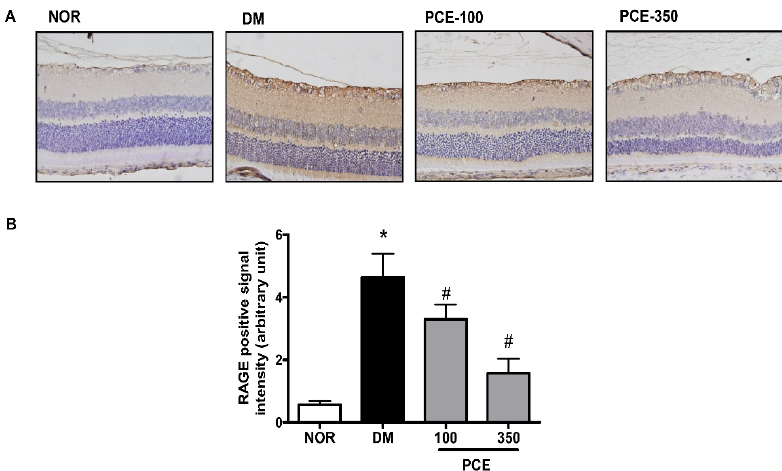
Figure 3. The effect of PCE on RAGE expression in the retina. ( A ) RAGE staining in the retina; ( B ) Morphometric analysis of the RAGE ‐ positive signal density in the retina in each group. Representative histological sections from a normal rat (NOR), an STZ ‐ induced diabetic rat (DM), a DM treated with 100 mg/kg PCE (PCE ‐ 100), and a DM treated with 350 mg/kg PCE (PCE ‐ 350). The nuclei were counterstained using hematoxylin ( blue ). Original magnifications: ×400. All data are expressed as the mean ± SEM ( n = 8). * p < 0.05 vs. the NOR group and # p < 0.05 vs. the DM group.